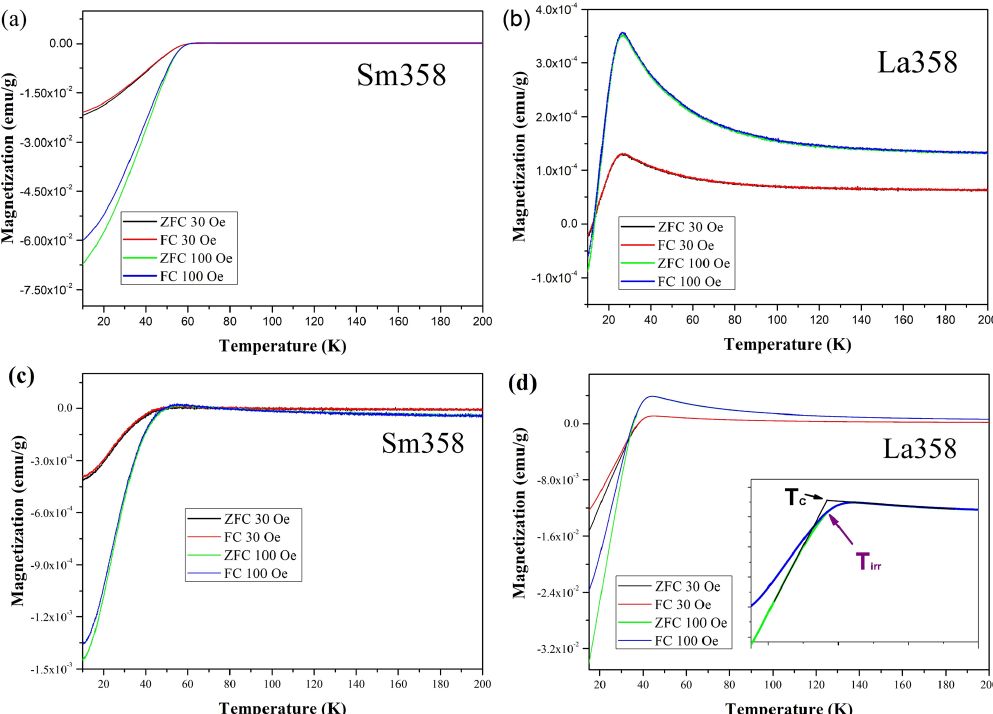
Ba Cu O and La Ba Cu O samples obtained by (a, b) combustion 3 5 8 18-δ 3 5 8 18-δ